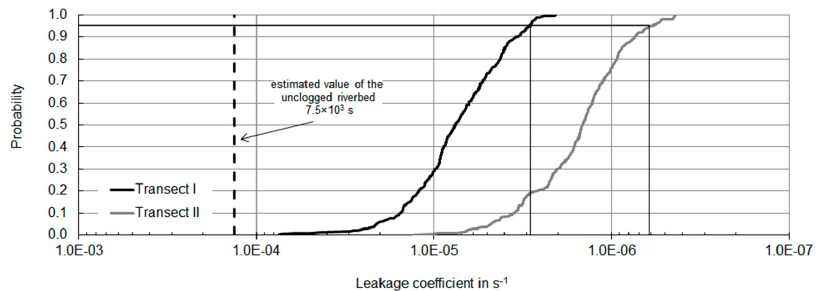
Figure 5. Probability plot for leakage coefficient at WW Dresden–Tolkewitz (2008–2015).